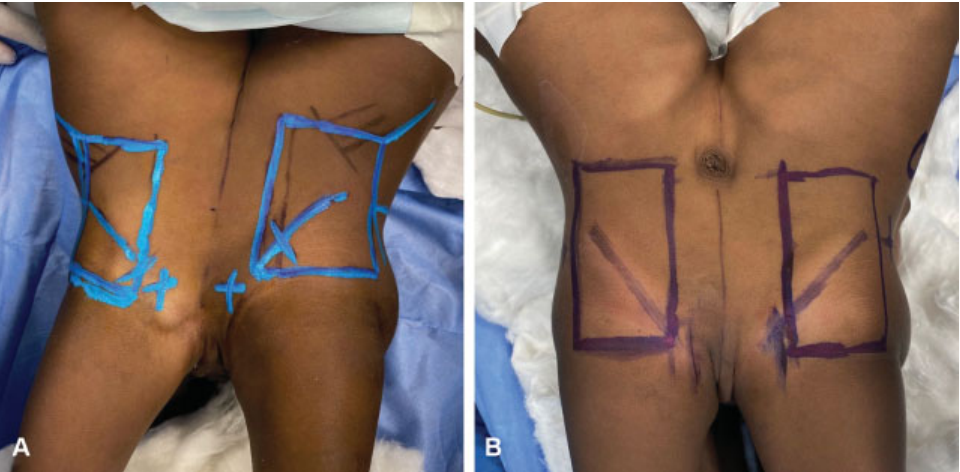
Fig. 3 ( A ) Site of pocket to receive tissue expander was made lateral to their line of fusion (midline) while resting on the iliac crest caudally and the last rib cephalically. The incision to insert each expander was made remote and perpendicular to longitudinal axis of the dissected pocket. ( B ) Same principles were applied when placing the second set of